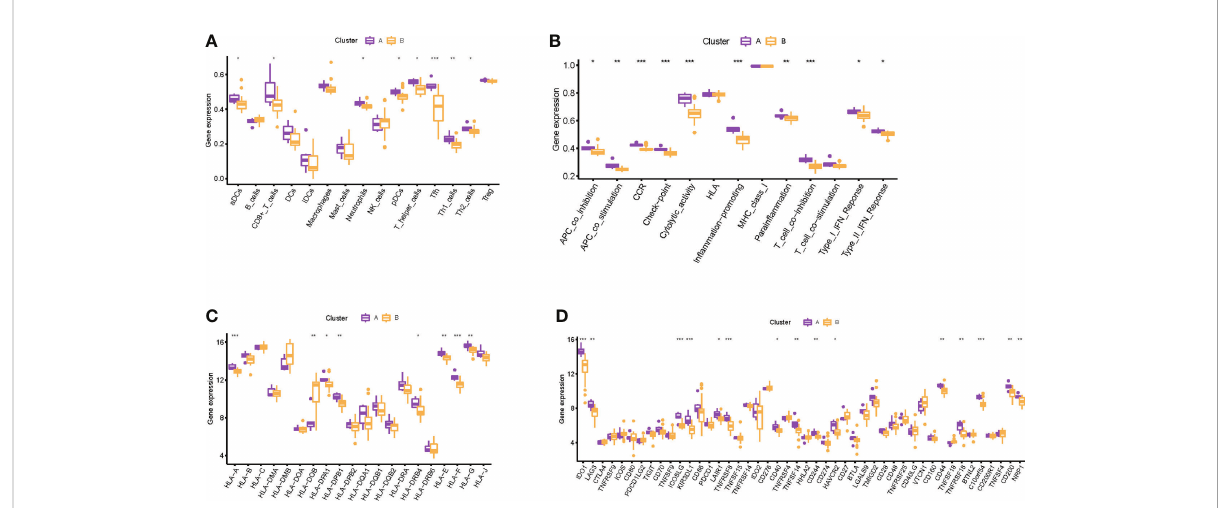
FIGURE 8 Immune-related in fi ltration landscape in RIF by unsupervised clustering based on the eight RIF signature genes. (A) The abundance differences of different immunocytes between the two subtypes. (B) The activity differences of different immune functions between the two subtypes. (C) The abundance differences of different HLA between the two subtypes. (D) The abundance differences of different immune checkpoints between the two subtypes. * represents P < 0.05 compared with cluster A, ** represents P < 0.01 compared with cluster A, and *** represents P < 0.001 compared with cluster